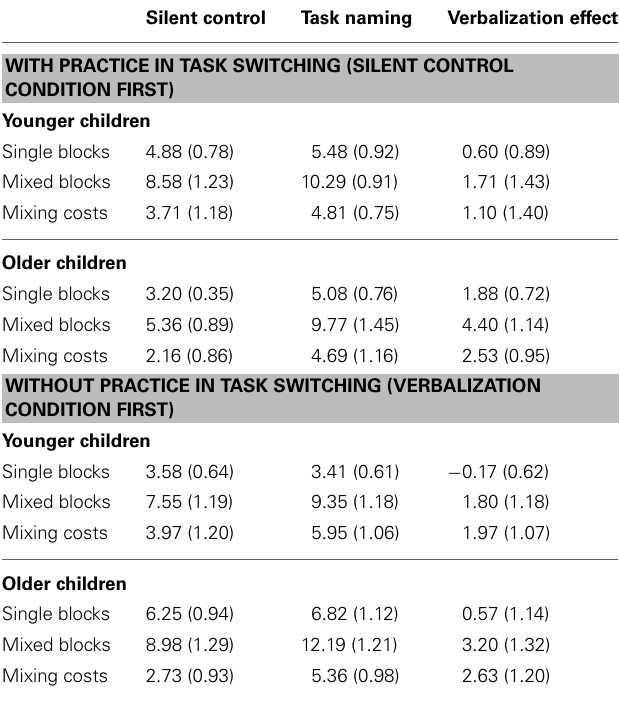
Table 2 | Mean error rates (SE) as a function of block type (single-task/mixed-task), age group (younger children/older children), verbalization condition (silent control/verbalization), and practice (silent control condition first/verbalization condition